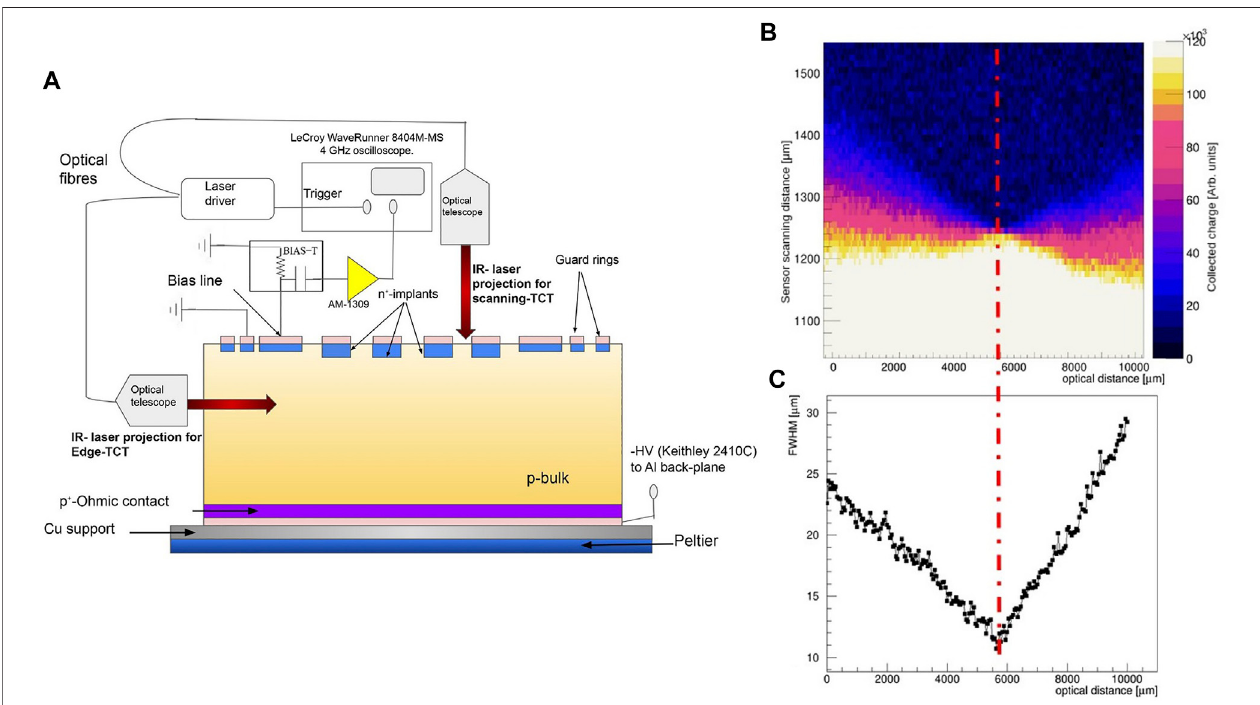
FIGURE 3 | (A) Schematic view of the TCT experimental setup (not to scale). Based on focus-scan performed by using the “ knife-edge ” technique (B) shows that the focused beam spot of the IR laser beam is at a distance of 5,850 μ m with respect to the edge of sensor and (C) the size (FWHM) of the laser spot at this focused position is of a magnitude of 12 μ